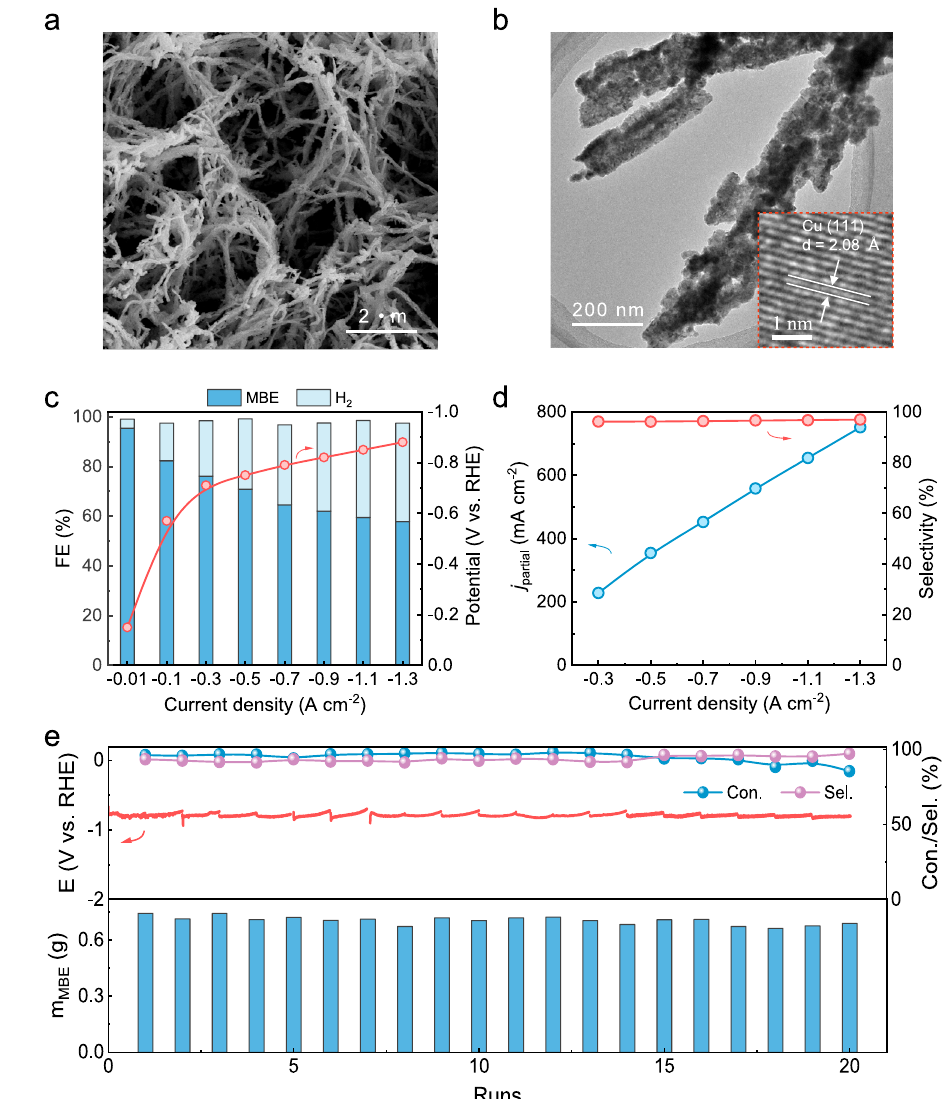
Fig. 2 | Electrocatalytic semi-hydrogenationperformance oftheCu NAs. a SEM imagesofCuNAs .b TEMandHRTEM(inset)imagesofCuNAs. c Faradaicef fi ciency distributions of the products and corresponding applied potentials at different current densities in the 1M KOH solution containing 0.5M MBY. d Partial current